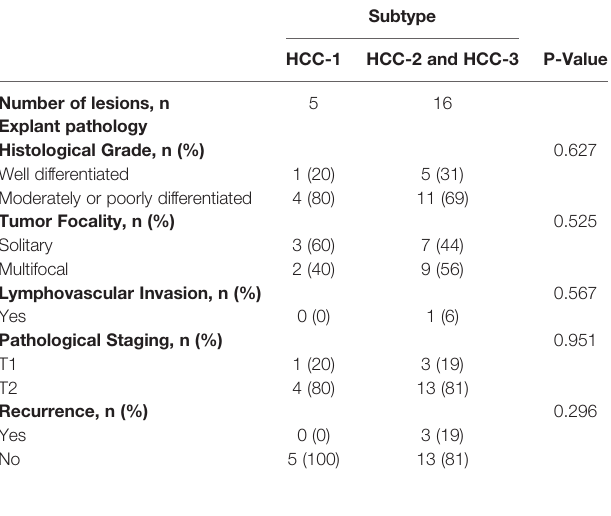
TABLE 7 | Explant characteristics and recurrence by subtype.